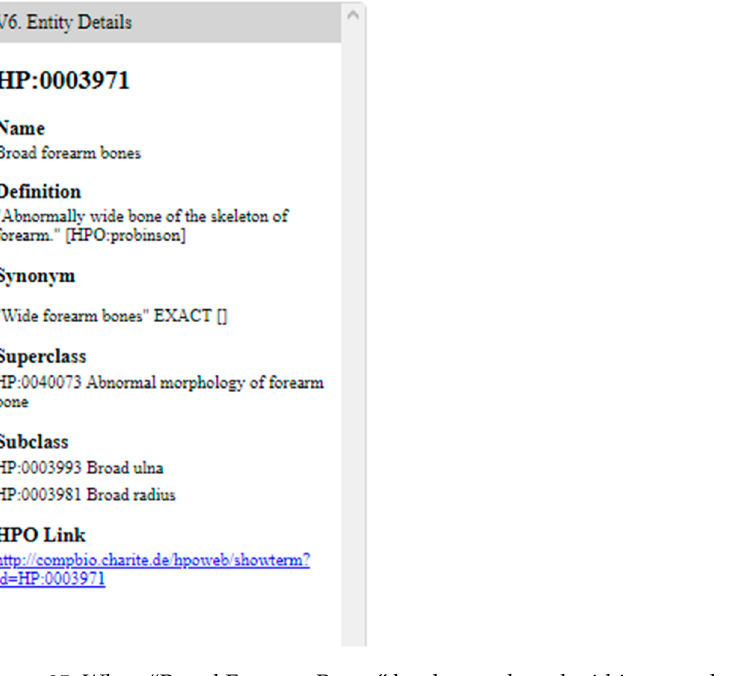
Figure 35. When “Broad Forearm Bones” has been selected within any subview, the Entity Details Panel subview depicts all information for that ontology entity as provided by